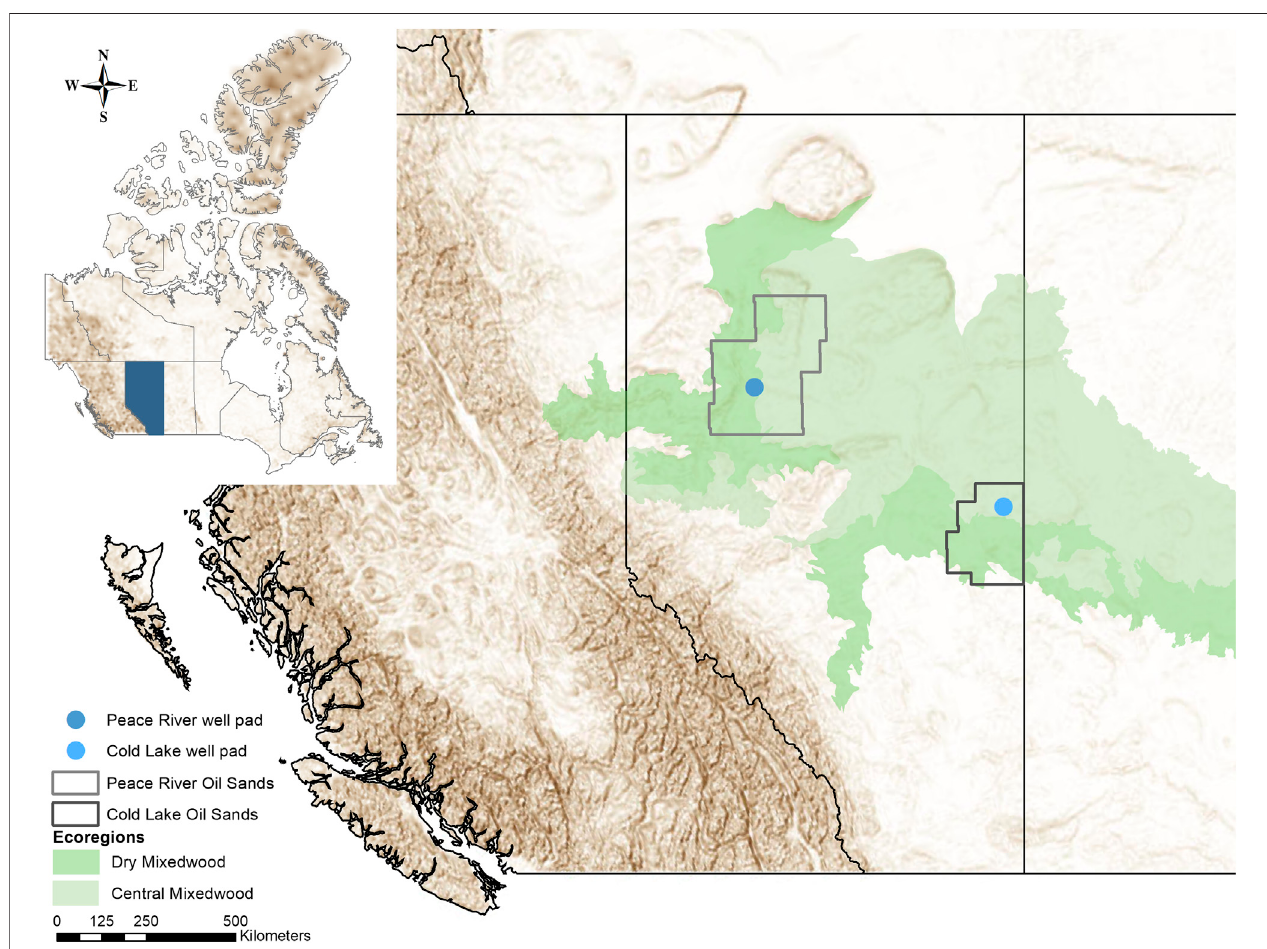
FIGURE1| Thestudysites,tworestored in-situ oilsandswellpads,situatedwithintheoilsandsregionsofPeaceRiverandColdLake.Bothsitesarelocatedinthe Boreal Mixedwood ecoregion of boreal Northern Alberta.